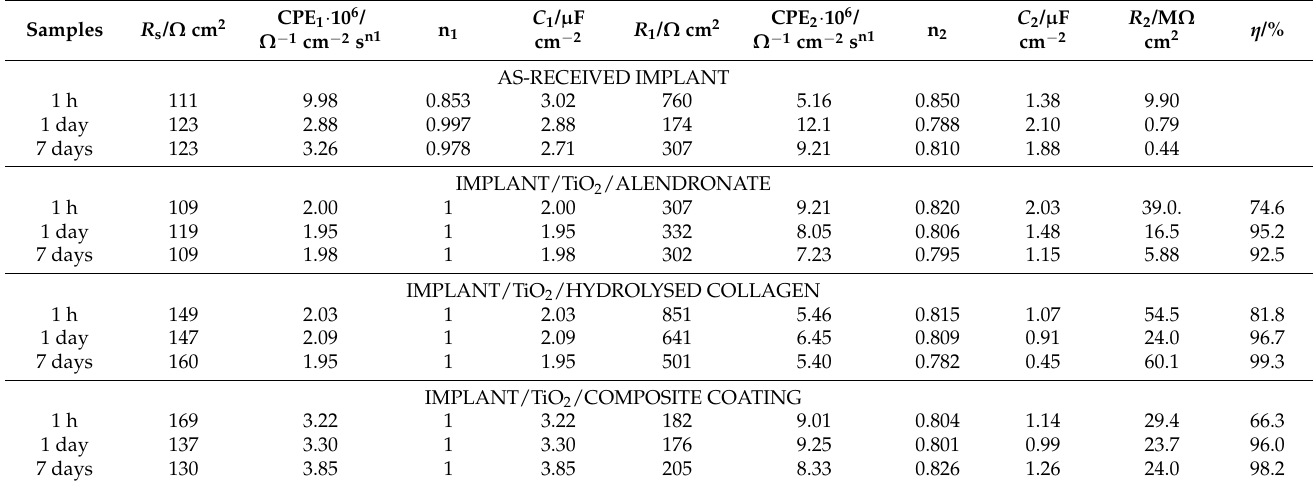
Figure 6. Bode plots of ( a ) as-received implant [13], ( b ) implant/TiO 2 /alendronate coating [13], ( c ) implant/TiO 2 /hydrolysed collagen coating, and ( d ) implant/TiO 2 /composite coating recorded after a stabilisation time of 1 h, 1 day, and 7 days at the open circuit potential in the artificial saliva solution, pH = 6.8. The insert: EEC used to model data. Table 1. Impedance parameters calculated from EIS data (Figure 6) for the as-received implant and functionalised implant samples.